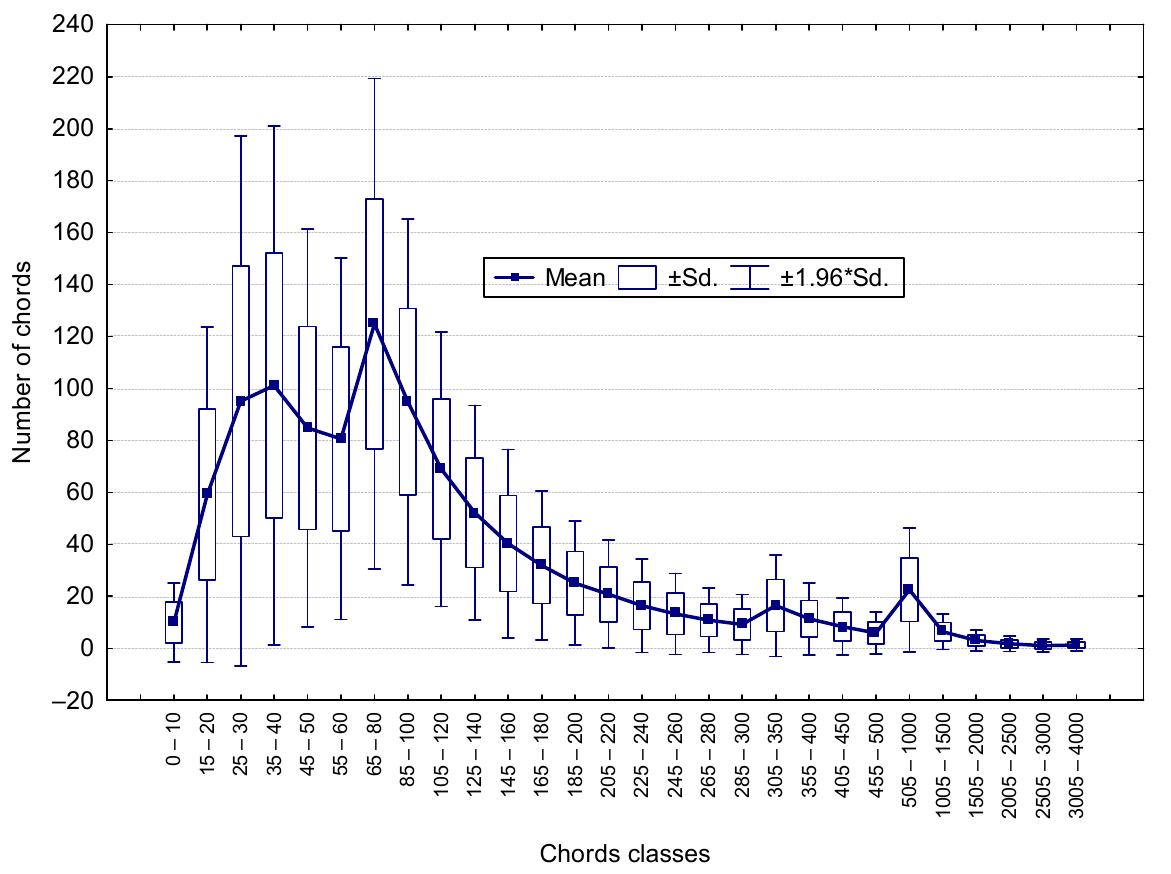
Figure 3. Characteristics of the distribution of the number of chords in each class. Stage 1 : Analysis of the dataset including all 28 chord classes The dataset for the calculations is shown schematically in Table 2. Table 2. Schematic of the table adopted for multiple regression